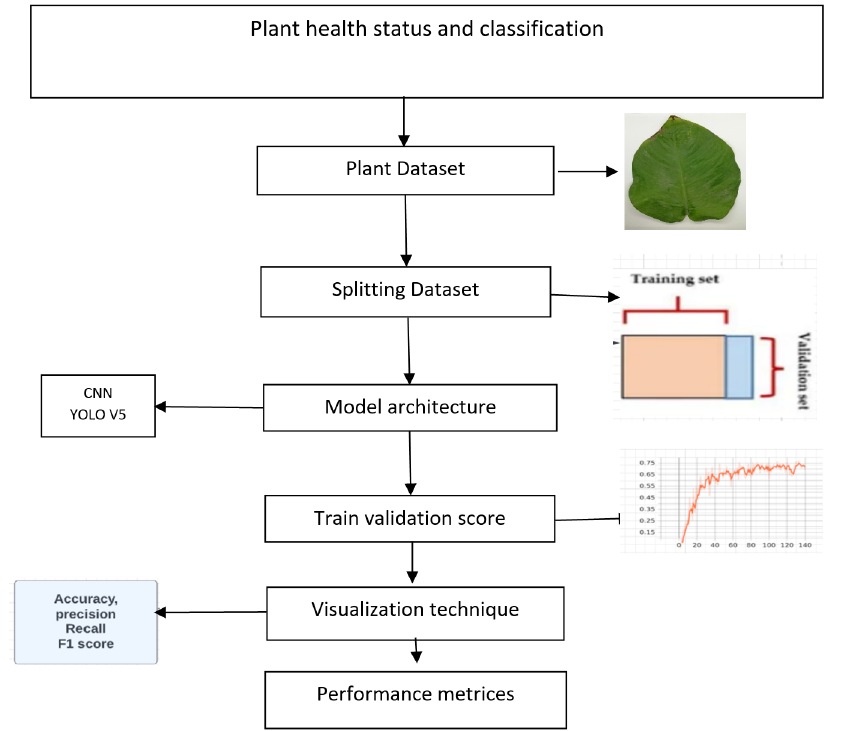
Figure 3. Plant disease identification step-by-step